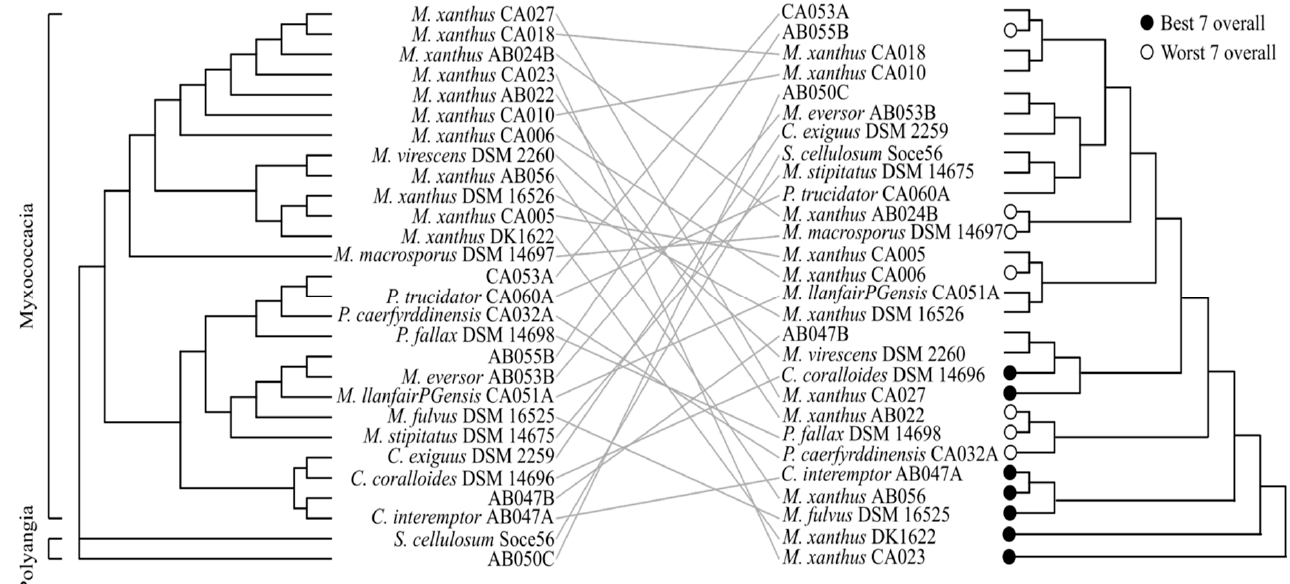
Figure 4. ANI distance tree and predation performance tanglegram. ANI similarity ( Left ) does not reflect predation performance ( Right ). ANI distancing clustered myxobacteria into two classes, Myxococcacia and Polyangia , and separated the Myxococcacia by genera. Hierarchical clustering of predation performance: black and white points indicate the ‘best’ and ‘worst’ seven overall predators, respectively.